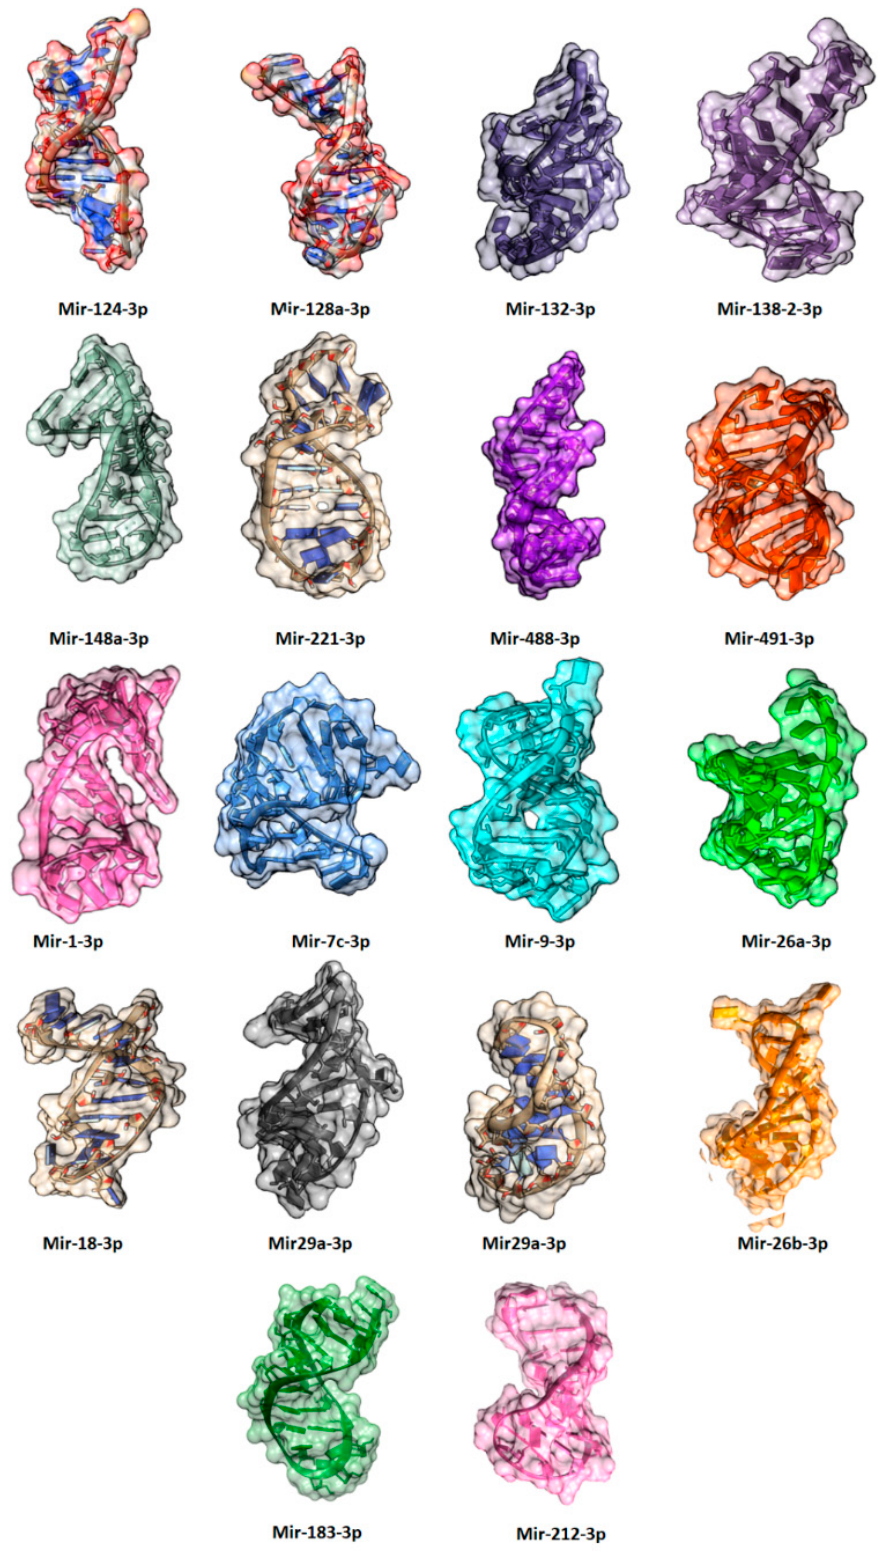
Figure 6. The predicted three-dimensional (3D) structures of miRNAs involved in anxiety and de- pression.